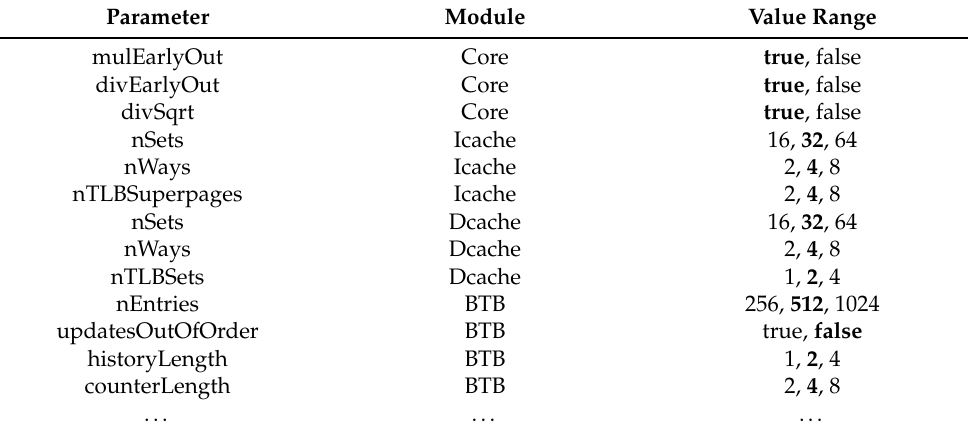
Table 2. The portion of parameters set with value range.